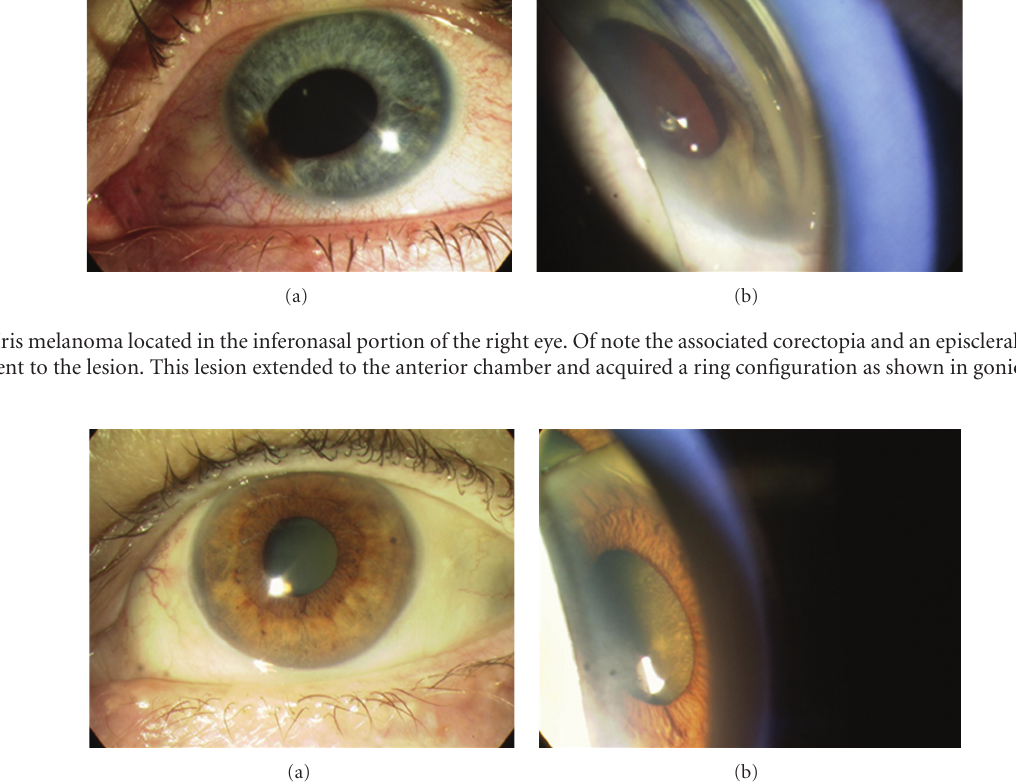
Figure 3: Ciliary body melanoma (a) pigmented area with associated sentinel vessel nasally. (b) gonioscopy reveals the underlying